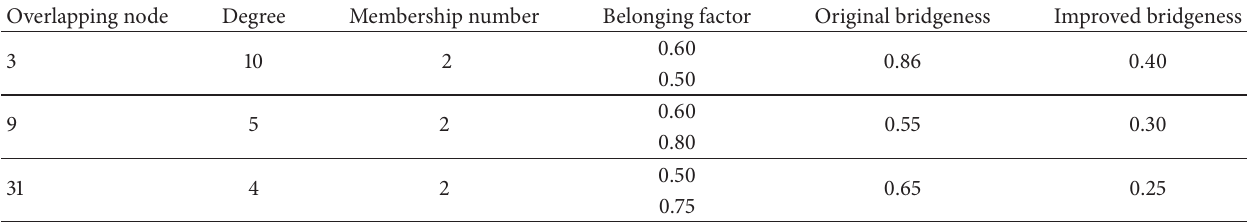
Table 2: The detailed information of overlapping nodes in Karate club network.